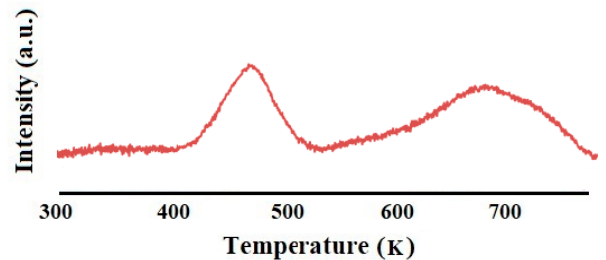
Figure 7. H 2 -TPR of the structured catalyst.